Question: Name the type of graph shown.
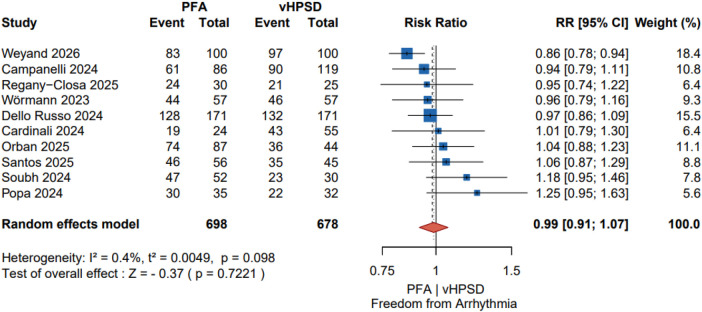
Answer: forest